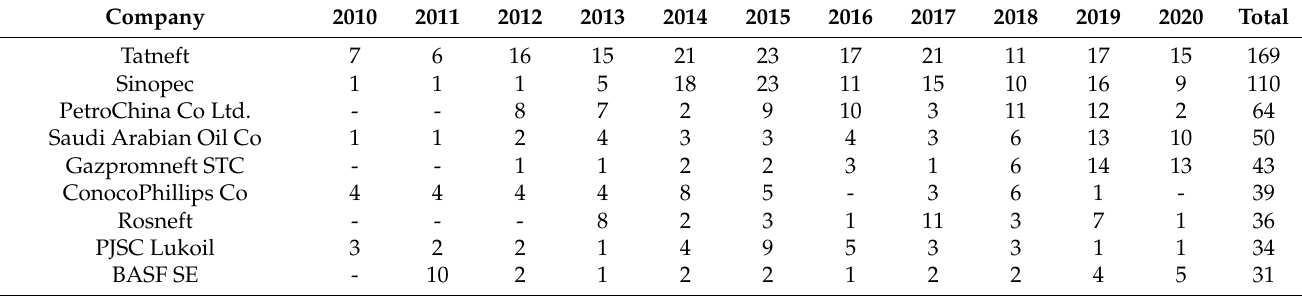
Table 4. Dynamics of patent activity of leading companies in the field of hydrocarbon production. Company